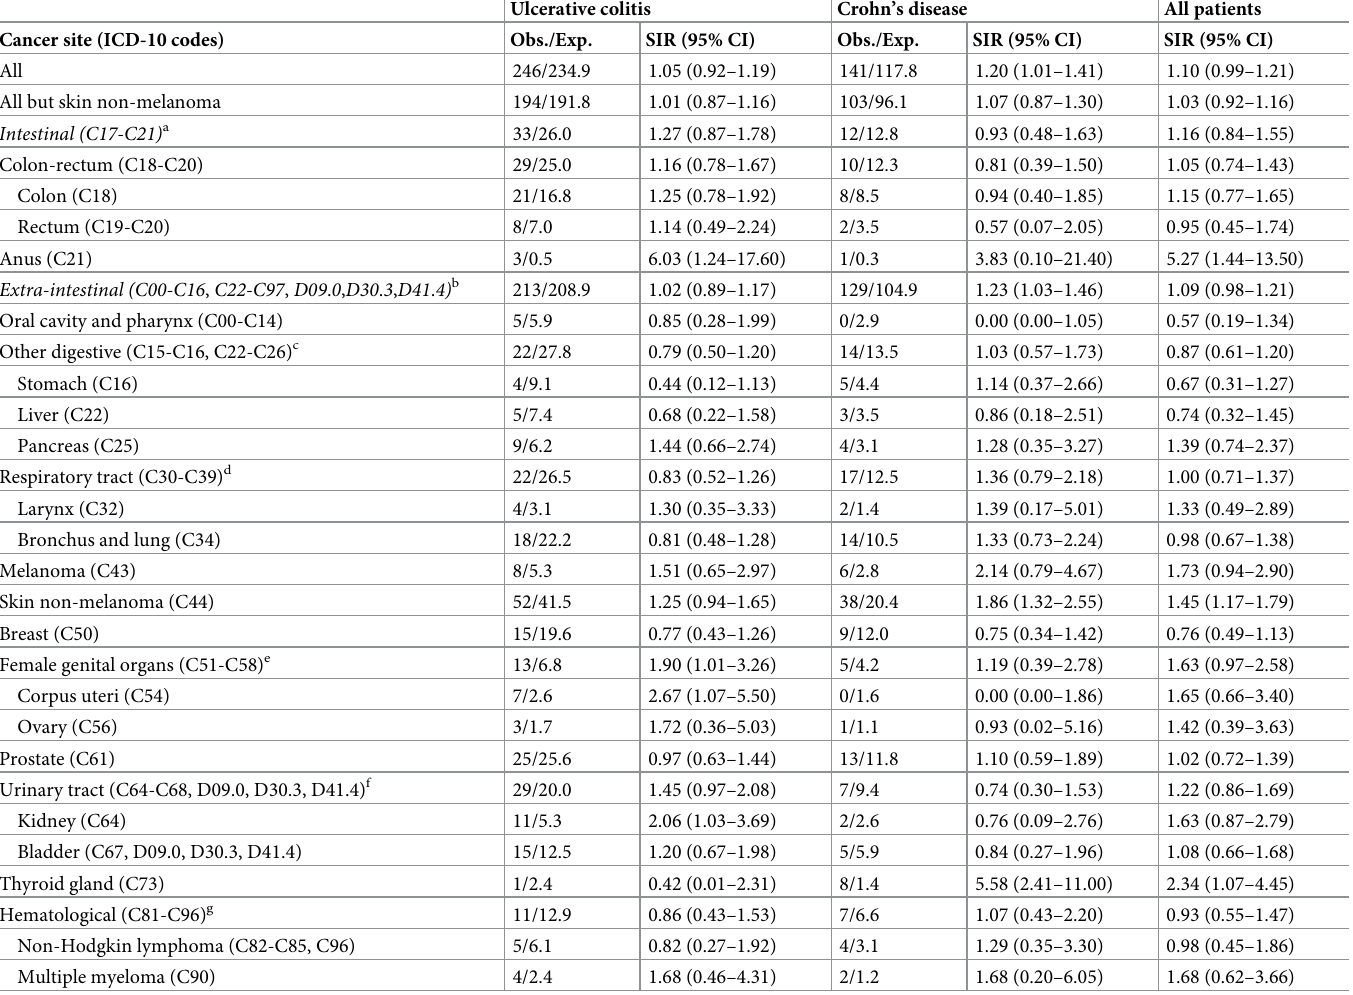
Table 2. Standardized Incidence Ratios (SIR) with corresponding 95% Confidence Intervals (CI) in patients with inflammatory bowel disease (IBD) for selected cancer sites, according to IBD type. Friuli Venezia Giulia, northeastern Italy,